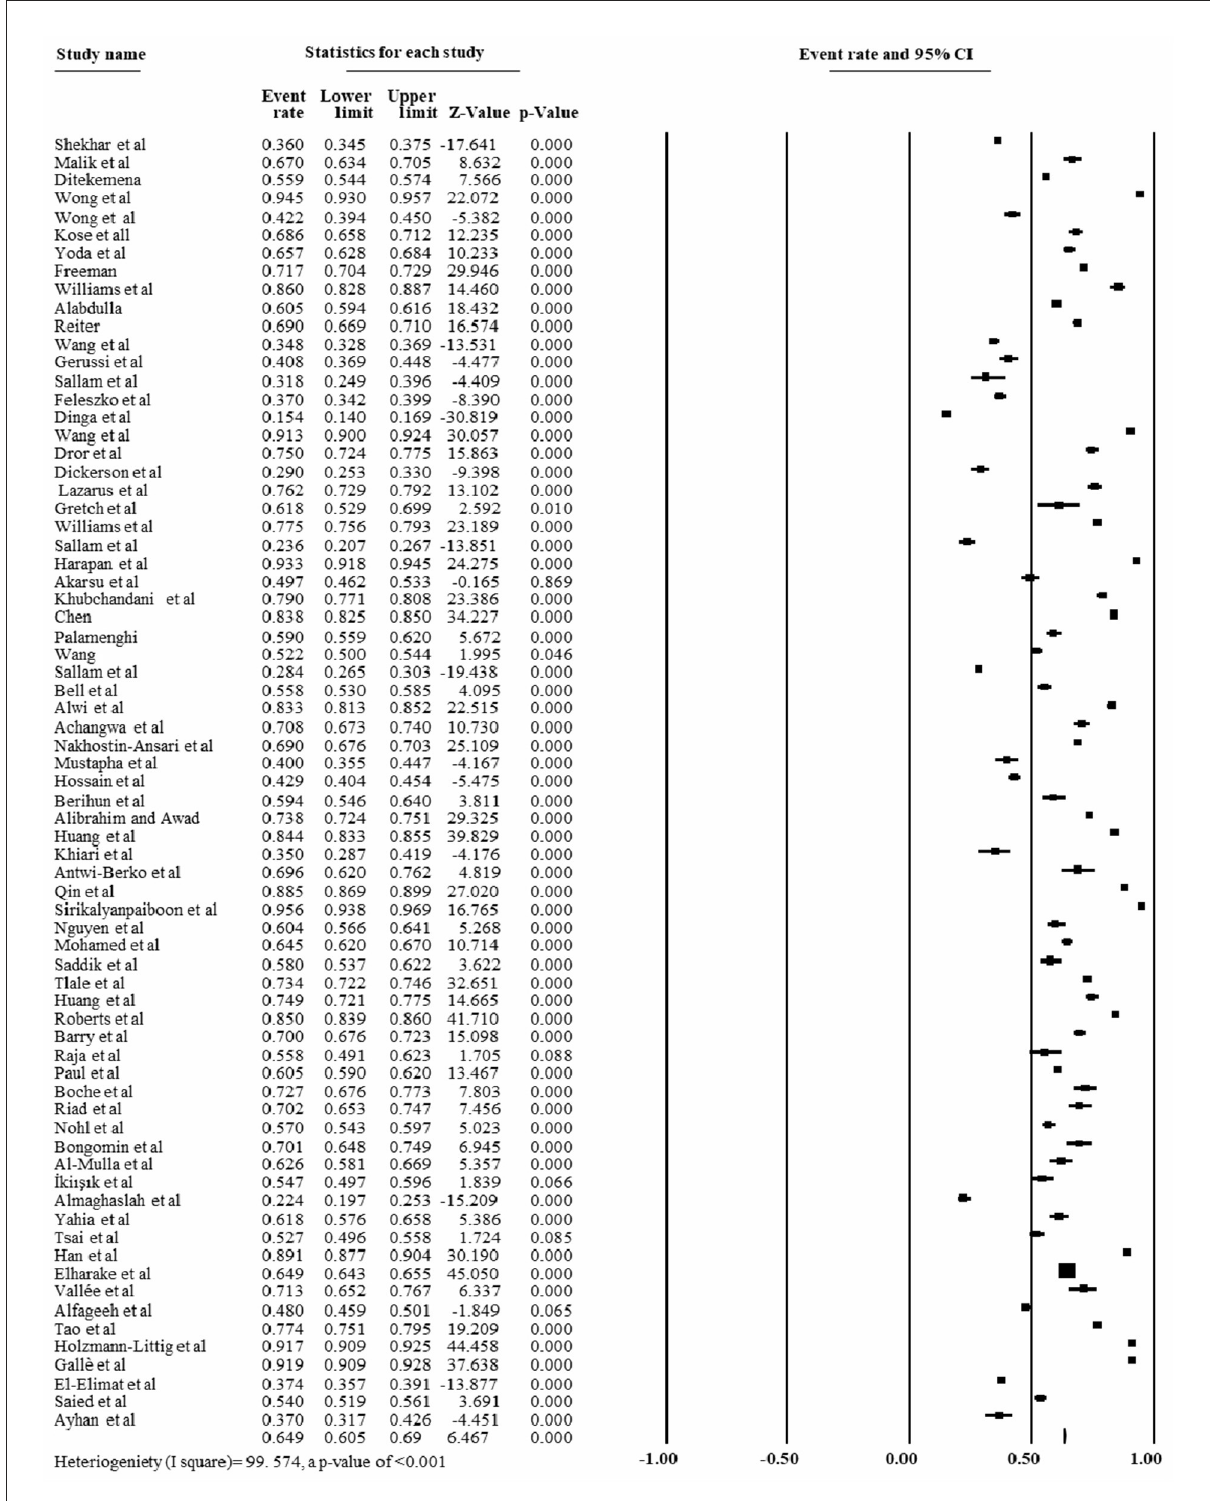
FIGURE4 Forest plot shows the overall pooled COVID-19 vaccine acceptance rate,